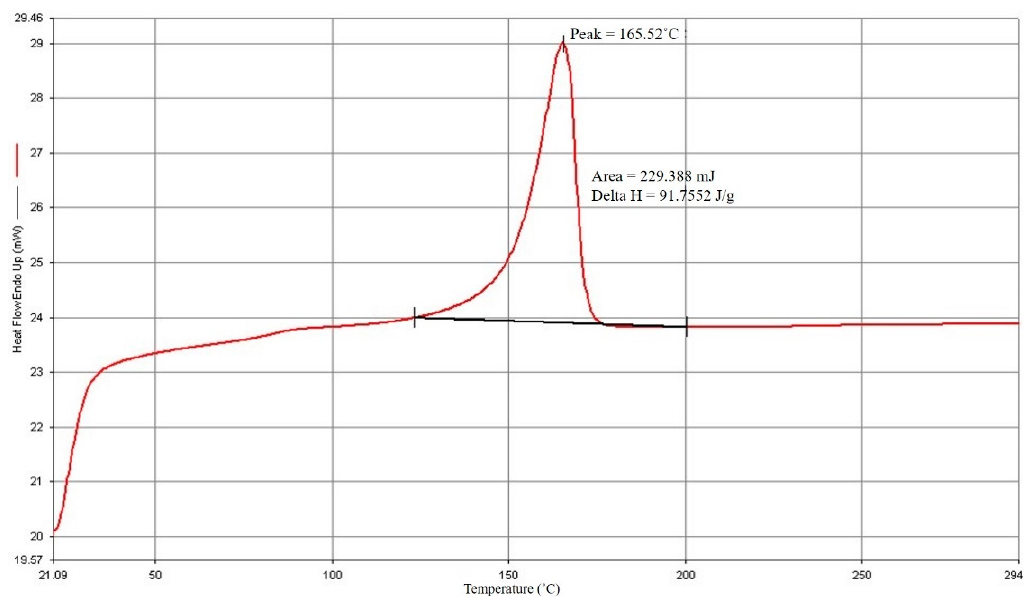
Figure 1. Analysis of thermo gravimetric loss of PP.